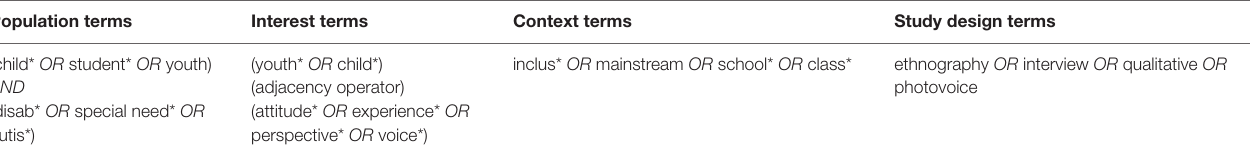
TABLE 1 | Example of database search